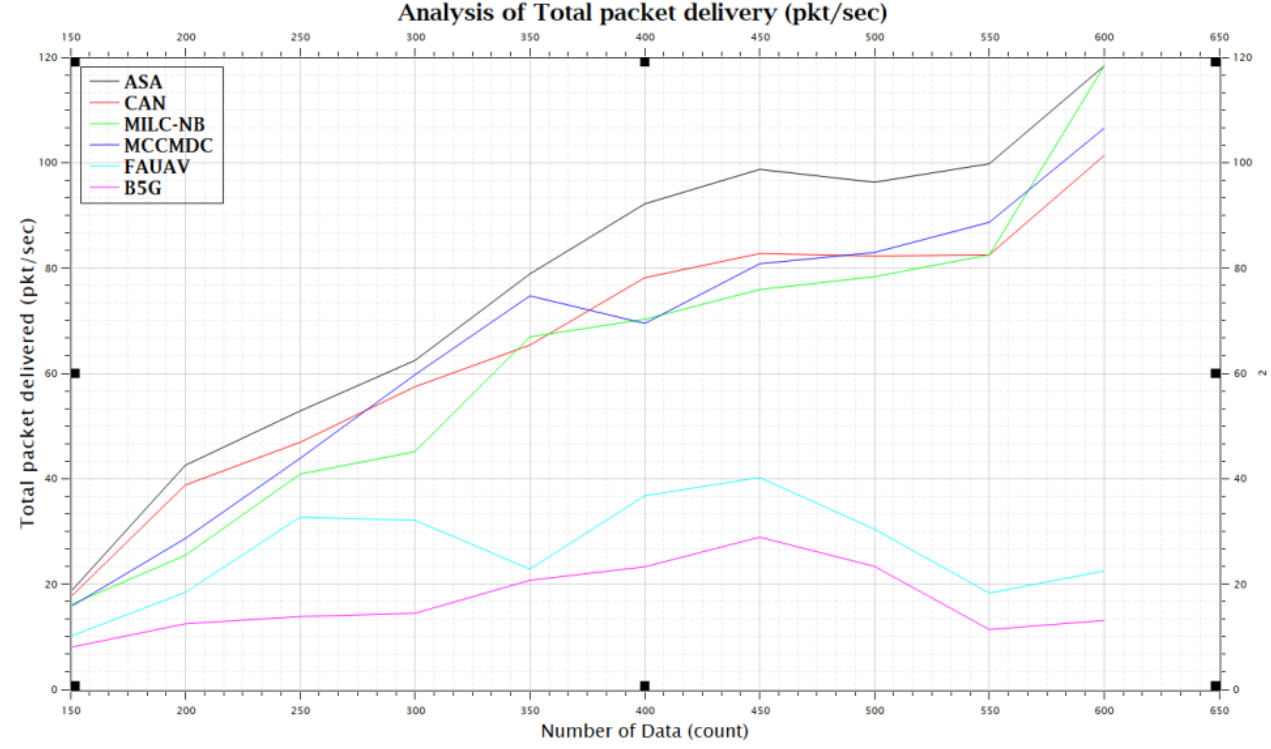
Figure 4. Packet delivery ratio before data obfuscation.